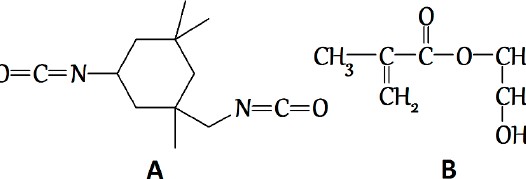
Figure 2. Structural formulas of the reactants used: ( A )—3-isocyanatomethyl-3,5,5-trimethylcyclohexyl isocyanate (ITI), ( B )—ethyleneglycol monomethacrylate (EGM). monomethacrylate (EGM). monomethacrylate (EGM).